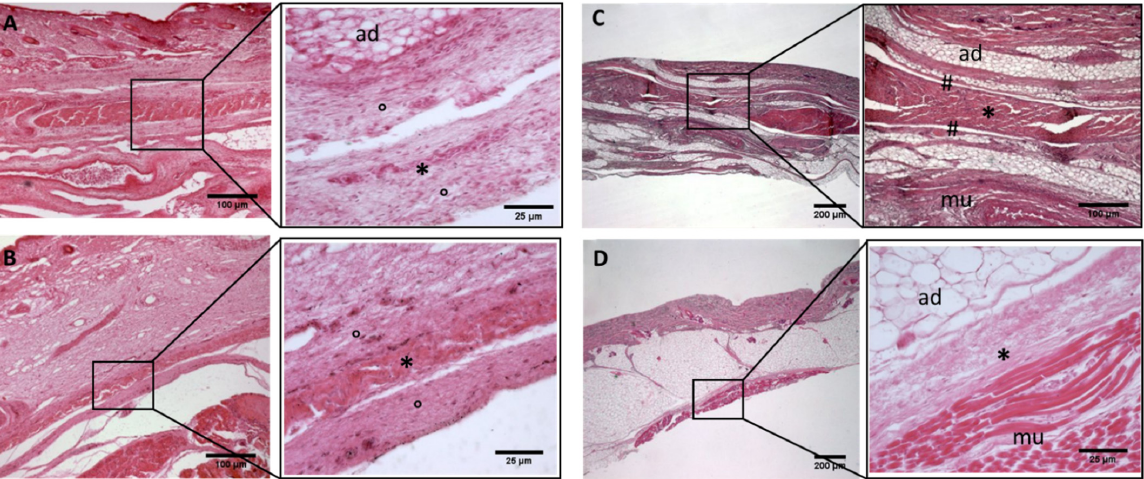
Figure 5. Histological images (hematoxilyn-eosin) of lower limb: extensor retinaculum develop- ment . ( A ): 24 weeks; ( B ): 29 weeks; ( C ): 38 weeks; ( D ): 40 weeks. (*): deep fascia; ( ◦ ): mesenchymal cells; (#): areolar tissue; (mu): muscle; (ad): adipose tissue. The first part of gestation is distinguished ( A , B ) by an irregular connective tissue, whilst the second part of the gestation ( C , D ) showed up with a denser connective tissue, which was better organized in the fascial layers.